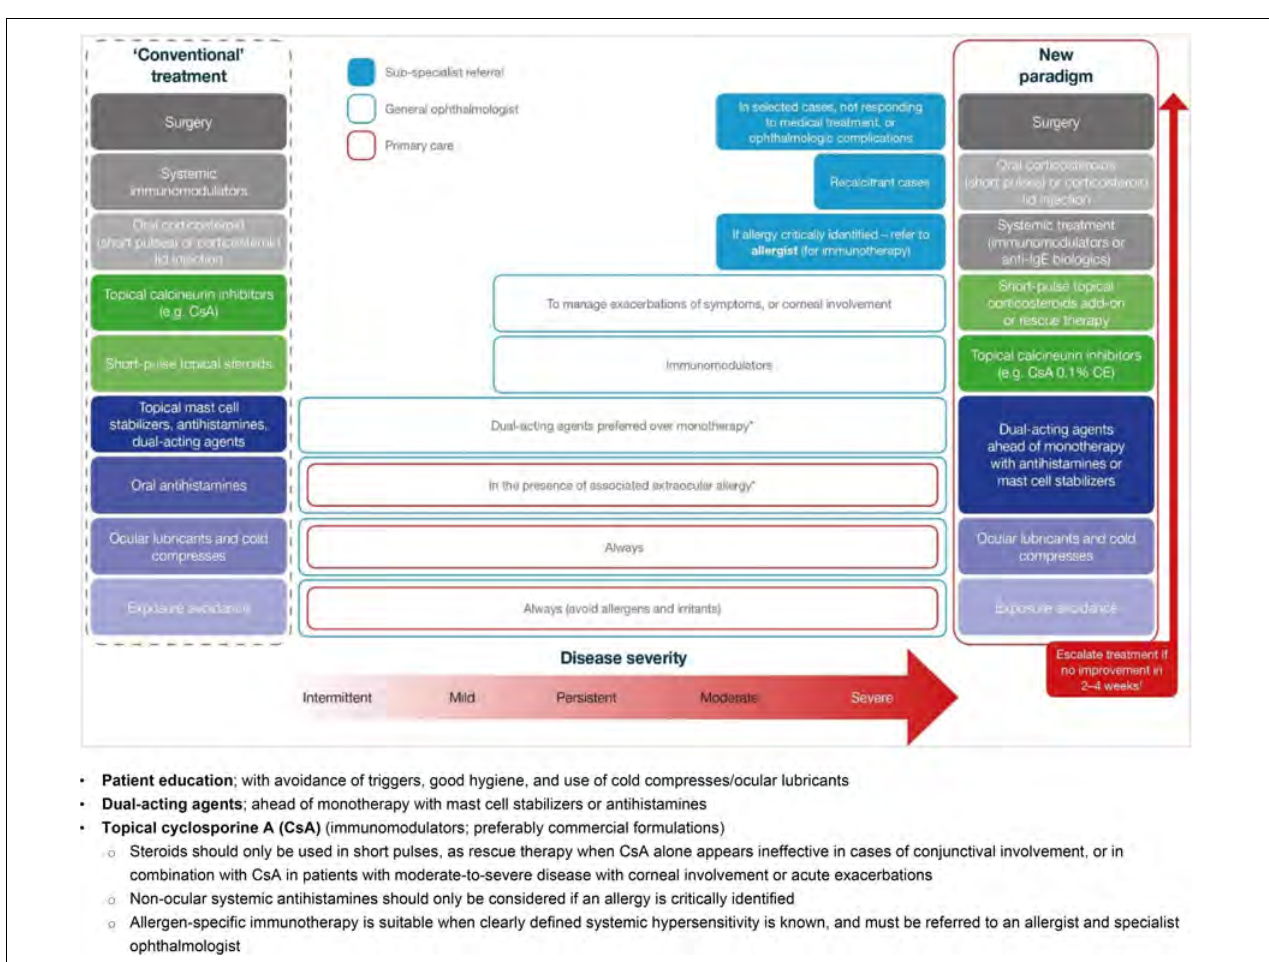
FIGURE 1 | A new paradigm for the stepwise management of VKC based on disease severity. Adapted from Leonardi et al. (28). *In the case of associated rhinitis, consider treatment according to Allergic Rhinitis and its Impact on Asthma (ARIA) protocol; † No improvement is defined as no improvement in symptoms or changes in conjunctival, papillary or ocular surface clinical signs. CE, cationic emulsion; CsA, cyclosporine A; IgE, immunoglobulin